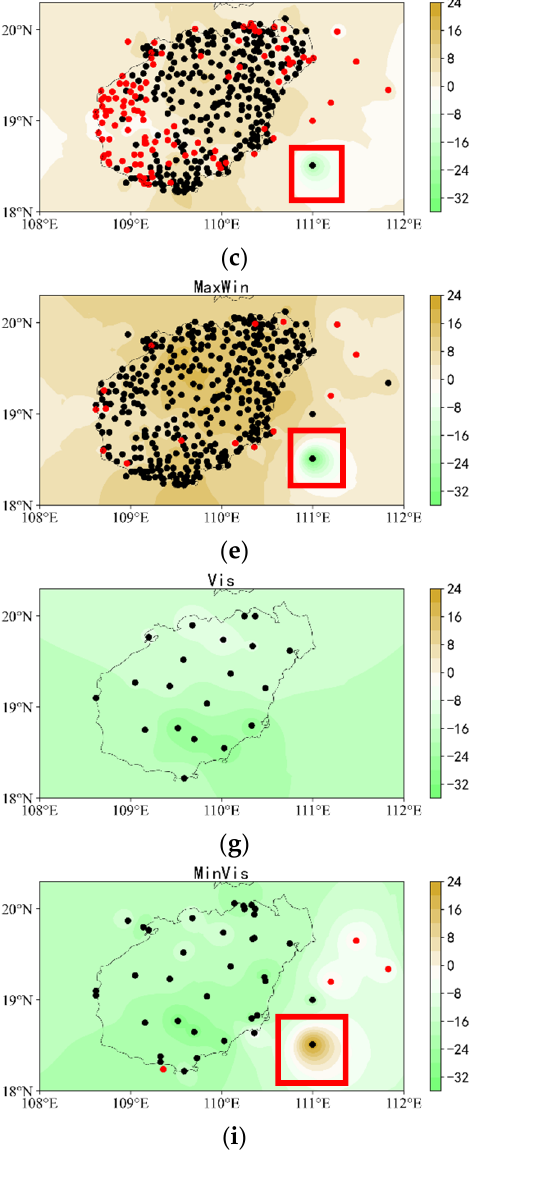
Figure 1. Distributions of hourly correlation coefficients between each reference weather component and precipitation in Hainan Province, from September 2020 to August 2021 (Station data are shown as black dots for those components that passed the 0.05 significance level test, and red dots for those that failed. An abnormal station whose correlation coefficient is opposite to that of other stations but has passed the significance test is marked on some subgraphs by red boxes). ( a ) Temperature; ( b ) dew point depression; ( c ) 2-minute mean wind speed; ( d ) extreme wind speed; ( e ) hourly maximum wind speed; ( f ) pressure; ( g ) artificial horizontal visibility; ( h ) 10-minute mean visibility; ( i ) hourly minimum visibility; ( j ) relative humidity. Table 1. Correlation coefficients (CC) and percentages (P) of stations that passed the significance test for each weather component and hourly precipitation in Hainan Province, from September 2020 Based on the above, we chose atmospheric pressure, relative humidity, temperature to August 2021. difference, artificial horizontal visibility, and extreme wind speed as reference weather components for hourly